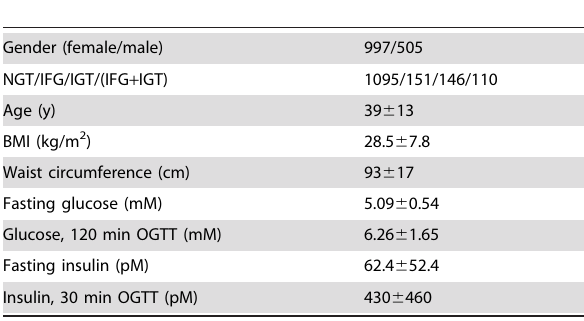
Table 1. Clinical characteristics of the study